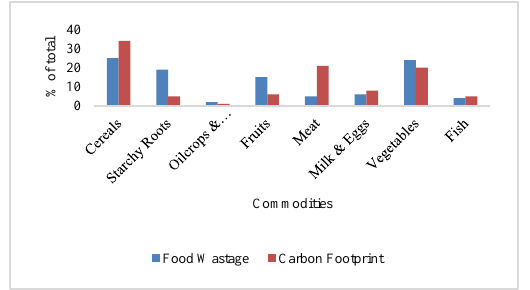
Figure 3: Carbon Footprint of food wastage by commodity (FAO, 2011a)